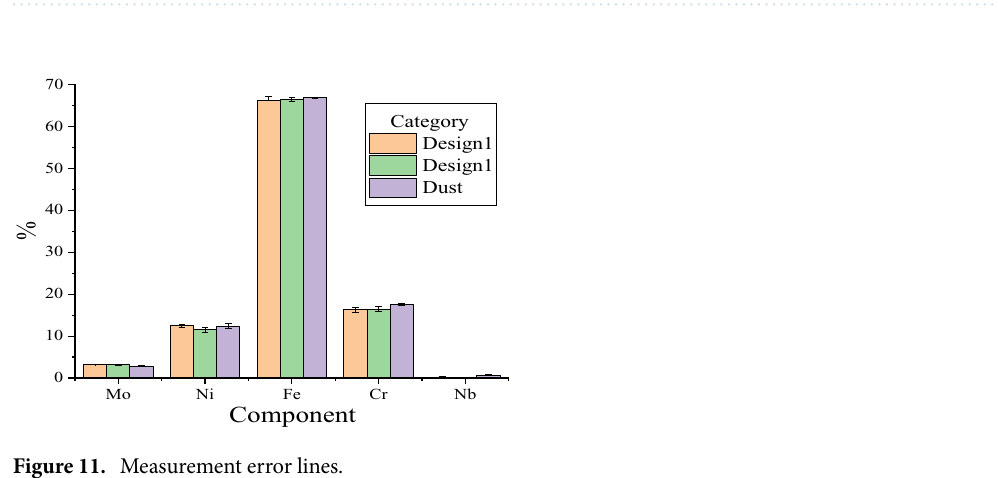
Table 2. Component comparison of SLM forming equipment with different inlet deflectors.